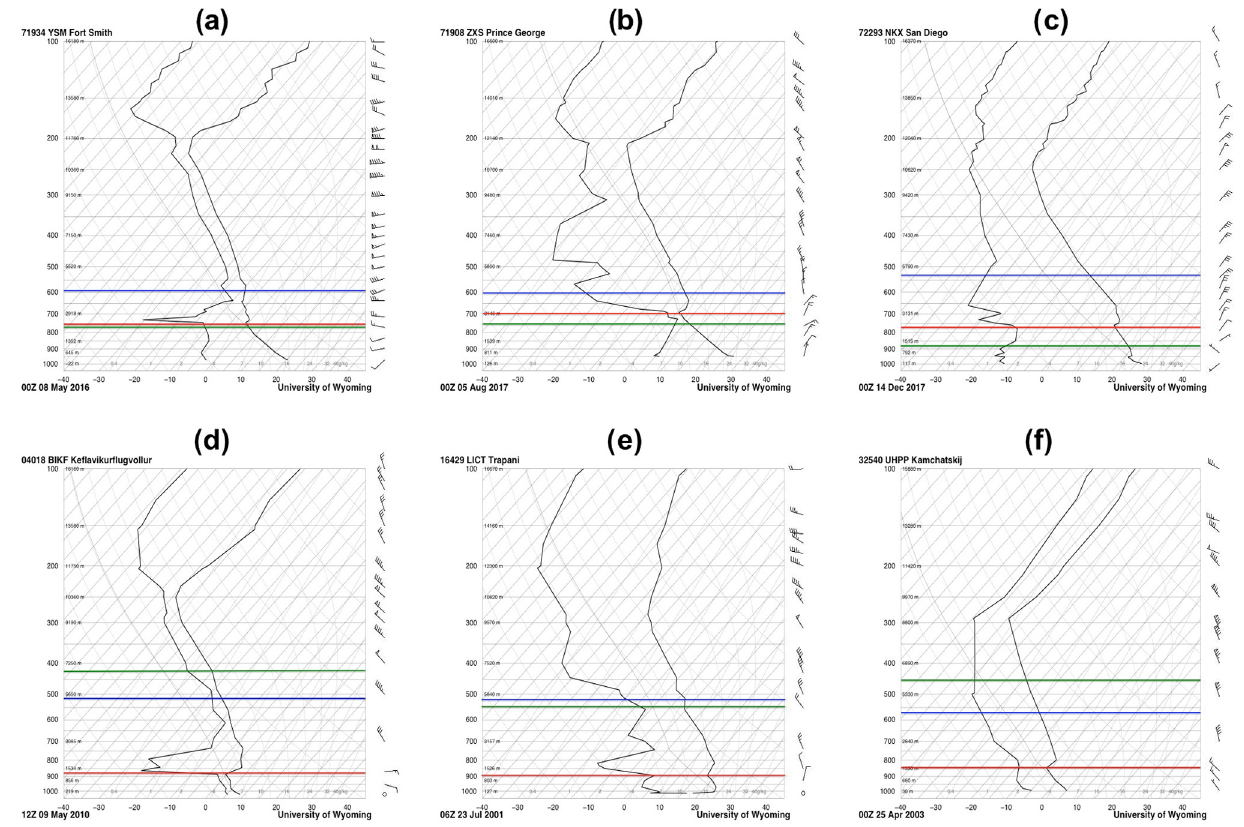
Figure 3. Atmospheric soundings at each of the nearest airports at the closest time to the snapshot for each case. The vertical axis is atmospheric pressure in mb on a log scale and the horizontal axis is temperature in ◦ C. Horizontal lines indicate approximate elevation in m, isotherms are indicated as light grey lines from lower left to upper right, and those generally trending toward the upper left are dry adiabats. The rightmost dark black line shows the temperature sounding, and the one to the left represents the dew point profile. Wind speeds and directions are indicated by the barbs on the right side of each plot. The red line marks the planetary boundary layer, the blue line marks the injection height of the MISR-initialized simulation, and the green line marks the injection height of the nominal simulation at the hour of the snapshot. (a) Fort McMurray, 8 May 2016, at 00Z: pbl ∼ 2 . 5km, MISR-initialized = 4 . 2km, nominal ∼ 2 . 4km. (b) Fraser Plateau, 5 August 2017, at 00Z: pbl ∼ 3 . 1km, MISR-initialized = 4 . 2km, nominal ∼ 2 . 7km. (c) Thomas fire, 14 December 2017, at 00Z: pbl ∼ 3 . 1km, MISR-initialized = 5 . 5km, nominal ∼ 1 . 9km. (d) Eyjafjallajökull, 9 May 2010, at 12Z: pbl ∼ 1 . 2km, MISR-initialized = 5 .